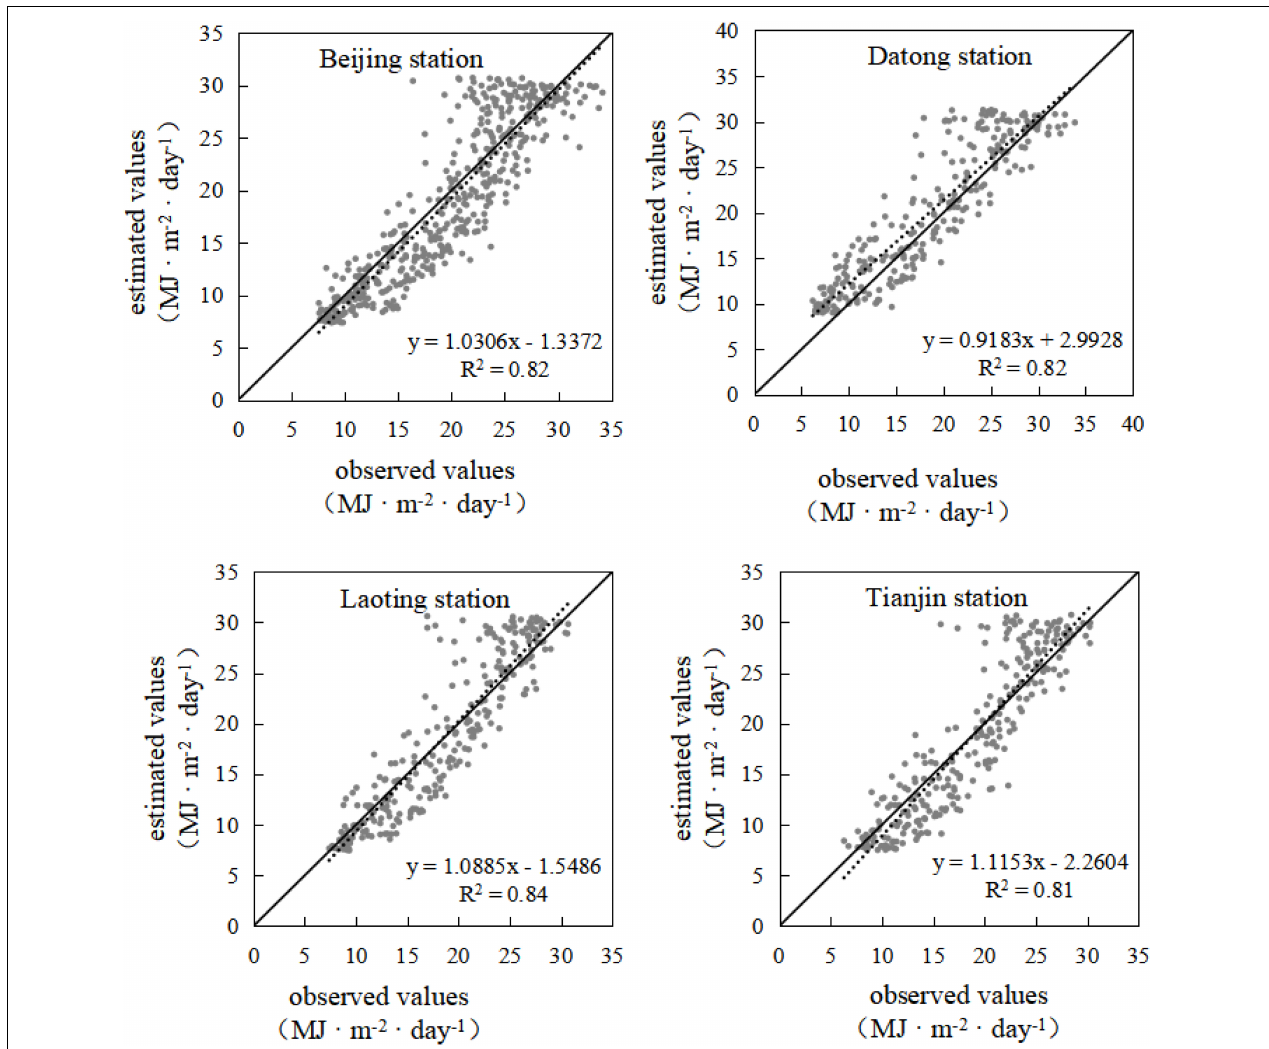
FIGURE 6 | Comparison of the estimated and observed daily solar incident radiation of the Haihe River Basin.